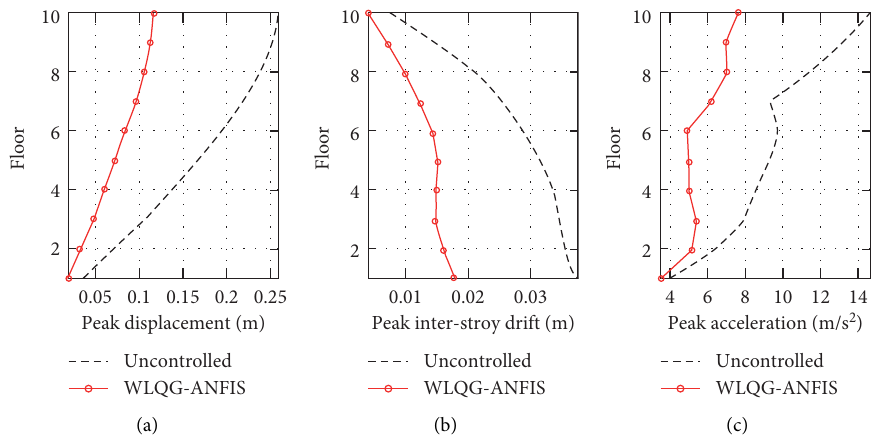
Figure 27: Peak responses with consideration of − 15% stiffness variation. Table 8: Maximum responses (reduction ratios) in different stiffness variation cases with the proposed control. Maximum responses Stiffness variation Control strategy x max (m) Unc. − 15% Unc indicates without control; Ctr indicates the proposed